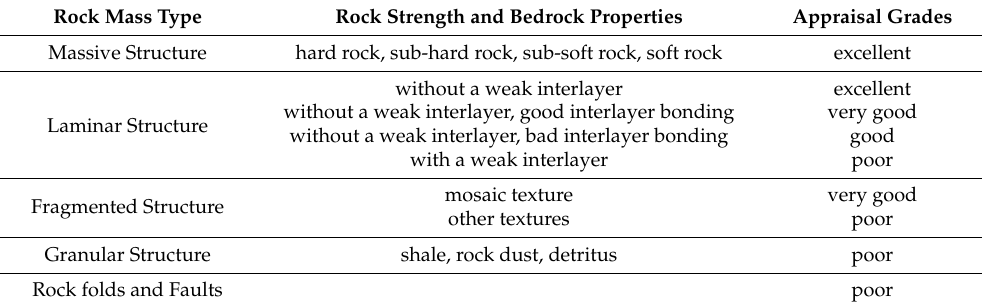
Table 2. Evaluation index of rock mechanics.